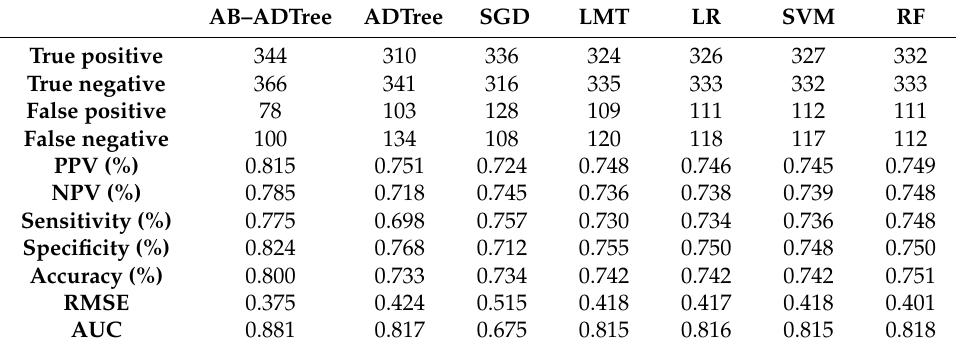
Table 4. GSPM model validation using training dataset. Abbreviations: LMT, logistic model tree; LR, logistic regression; SVM, support vector machine; RF, random forest; SGD, stochastic gradient descent; PPV, positive predictive value; NPV, negative predictive value; RMSE, root mean square error; AUC, area under the